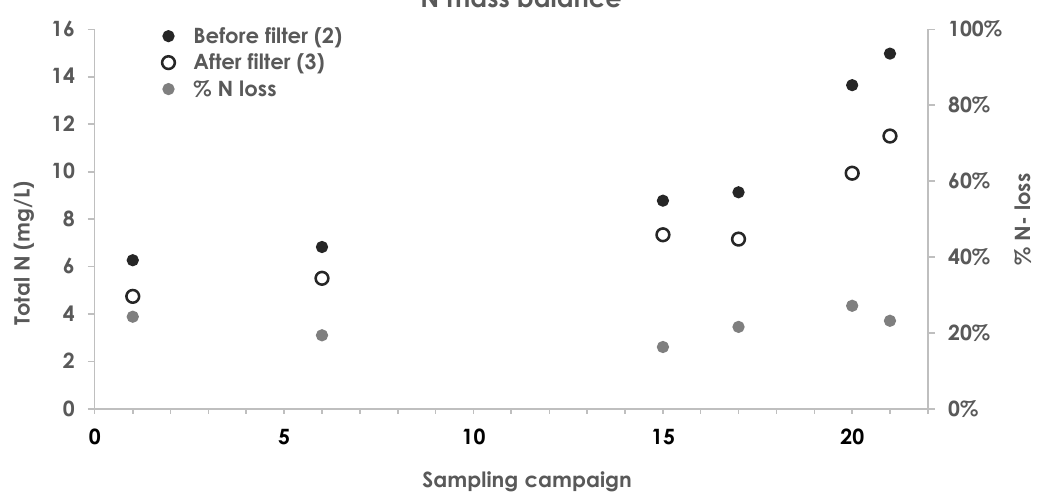
Figure 3. Accumulated inorganic and organic nitrogen concentrations (mg / L-N) before (BF) and after (AF) the biofilter and removal rates (%).